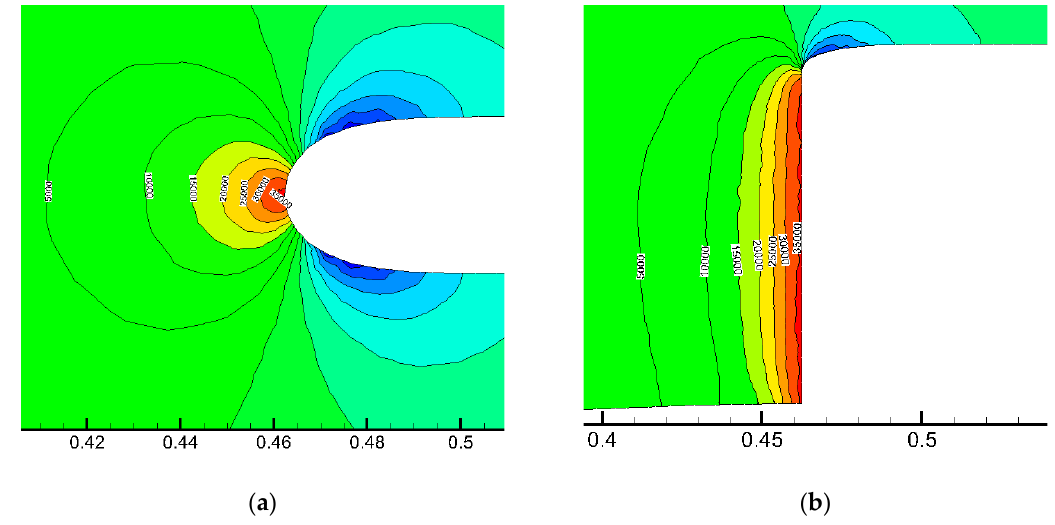
Figure 4. The pressure contour at the leading edge of Plane A and Plane B. The pressure is from 5000 Pa to 35,000 Pa, when the points are approaching to the leading edge. ( a ) Plane A; ( b ) Plane B.